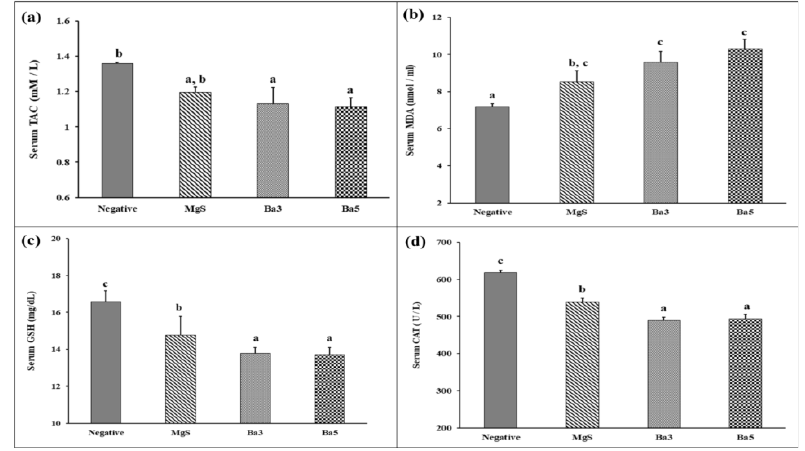
Figure 10. Effect of MgS nanopowders free from and doped with BaO on serum total antioxidant capacity (TAC), serum Malondialdehyde (MDA), glutathione reduced (GSH) and catalase (CAT) in tibia-fractured rats of different experimental groups: Sham Control, MgS, MgS doped with 3% BaO (Ba3) and MS doped with 5% BaO (Ba5). Data are presented as mean ± SE of mean. Statistical analysis was conducted using ANOVA followed by Duncan test ( n = 5, p ≤ 0.05). Means with different superscripts (a, b, c) are significant at p ≤ 0.05. Bars having the same superscripts are not significantly different from each other, while those having different superscripts are significantly different from each other. ( a ): TAC, ( b ): MDA, ( c ): GSH and ( d ): CAT.